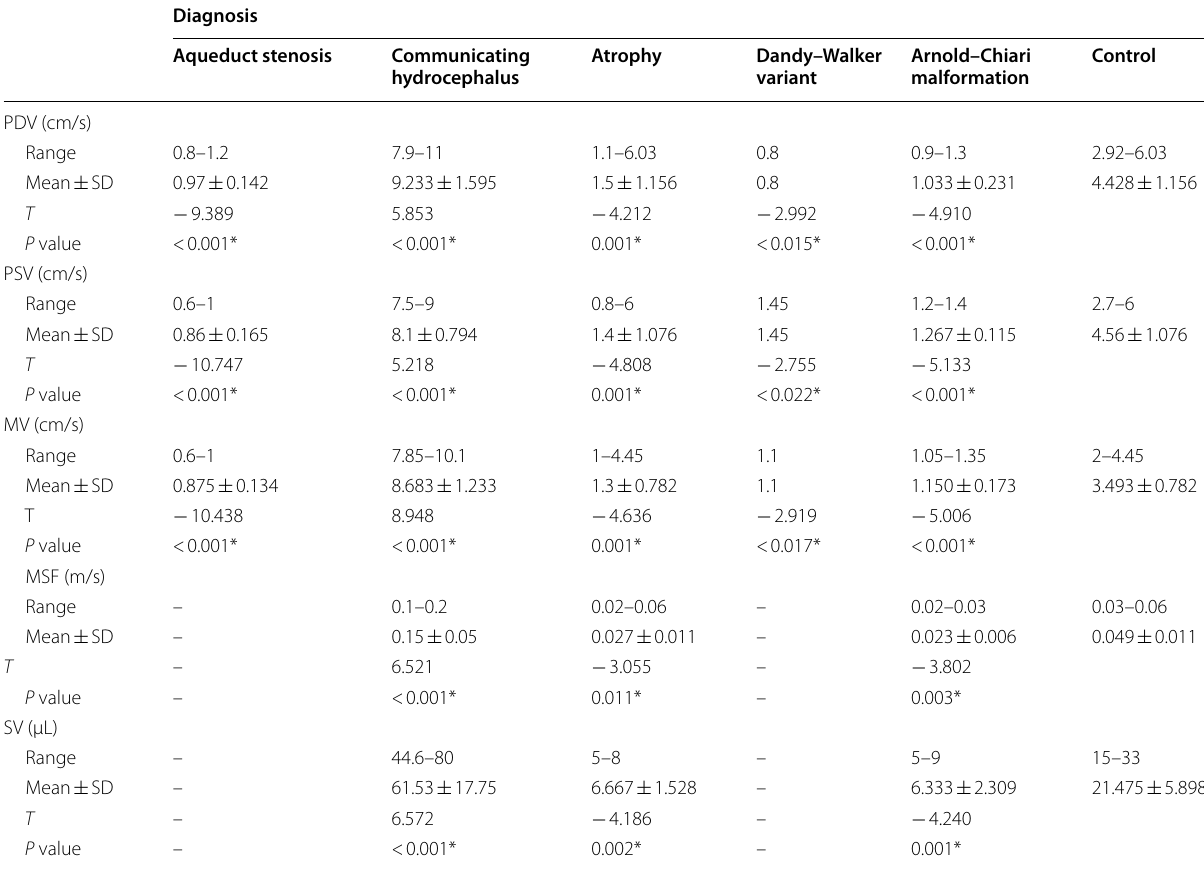
T Student’s t test = p value: probability for independent samples t test for association between patients and control group *Significant p <